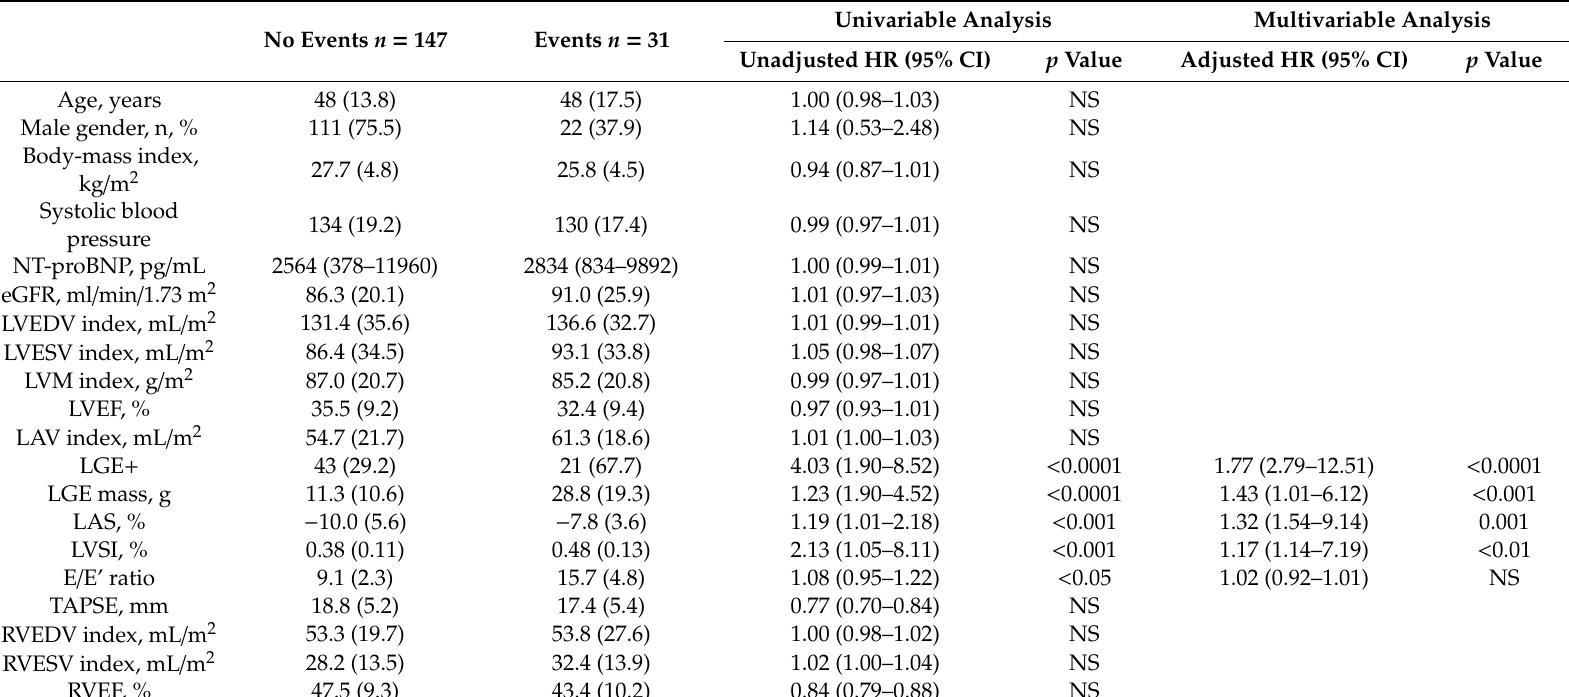
Table 3. Univariable and multivariable Cox analysis testing between studied parameters and